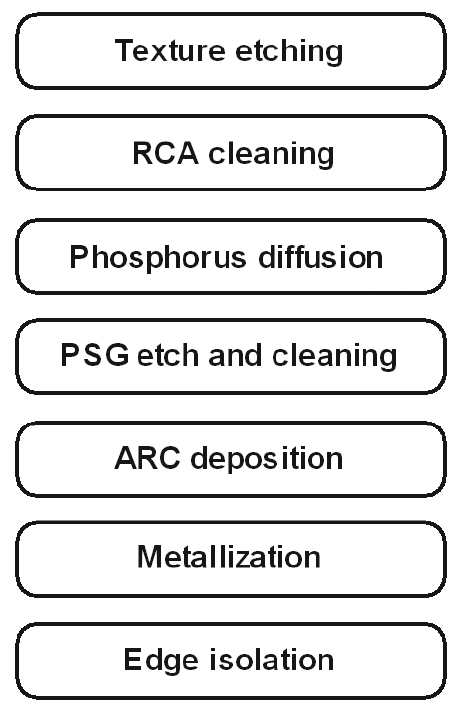
Figure 1. n + pn + silicon solar cell manufacturing